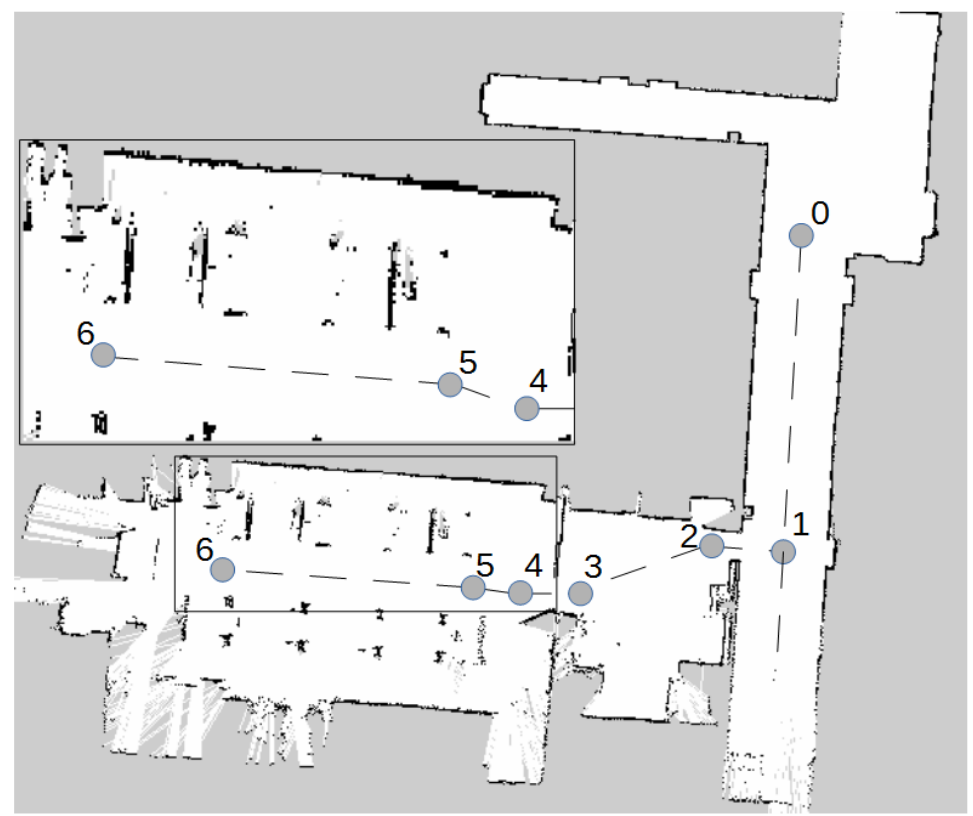
Figure 12. Map of the area with points of